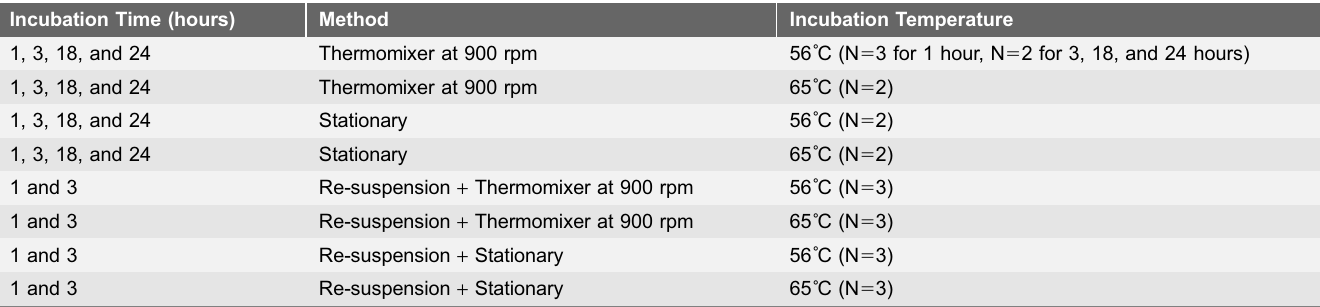
Table 1. Summary of extraction protocol alterations.